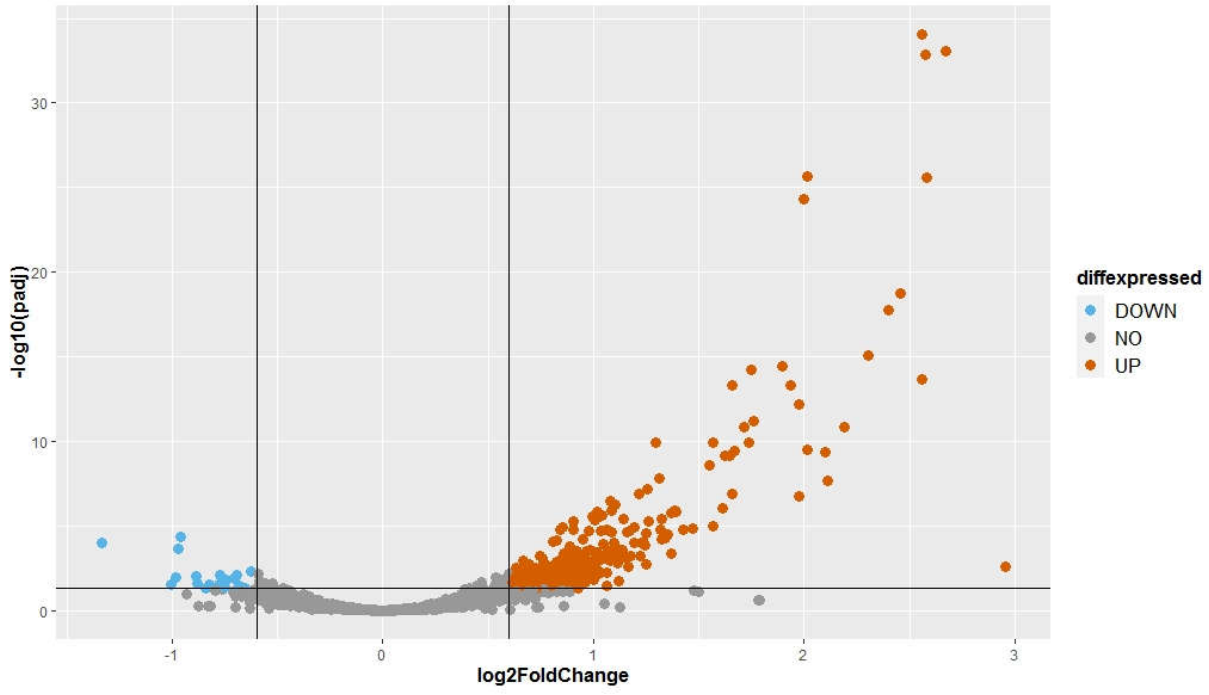
Figure 3. Volcano plot presenting the differential expression analysis of 3272 small RNA loci with a coverage ≥10 rpm. Fold change was obtained by comparing normalized reads counts of three virus-infected samples over the three virus-free samples. The adjusted p -values attained by the Wald test were corrected for multiple testing using the Benjamini Hochberg method (DeSeq2 package). A locus was considered to be statistically differentially expressed when its log2 (FC) ≥0.6 or ≤−0.6 and -log10 (padj) ≥1.3.